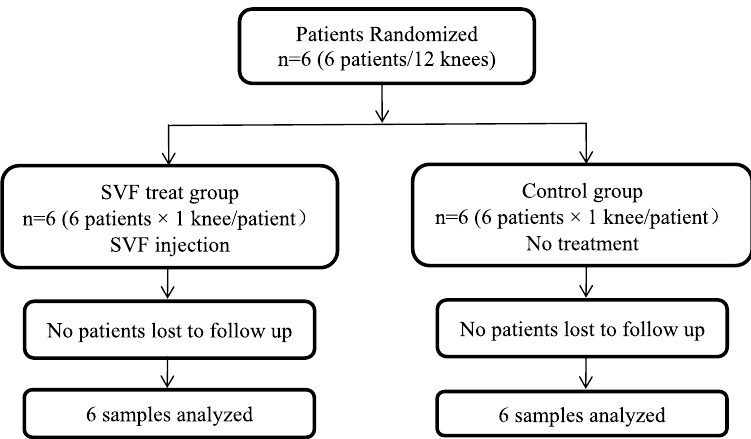
TABLE 1 The clinical trial design of the SVF cellular therapy with novel 3D MRI imaging for OA.